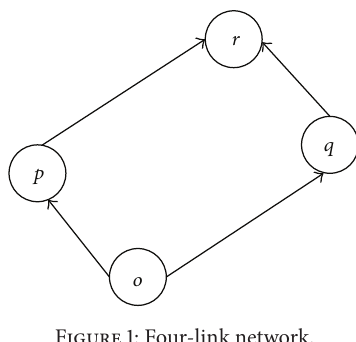
Figure 1: Four-link network.